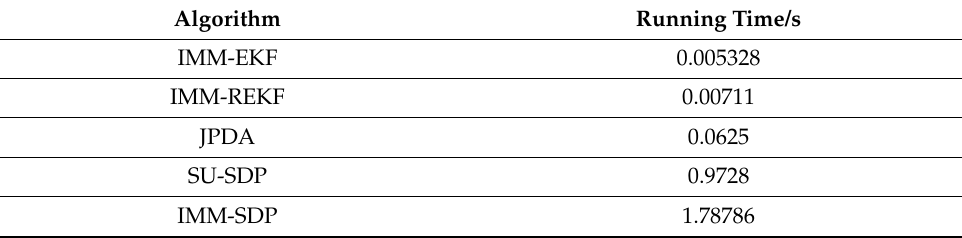
Table 4. Running time of each algorithm.